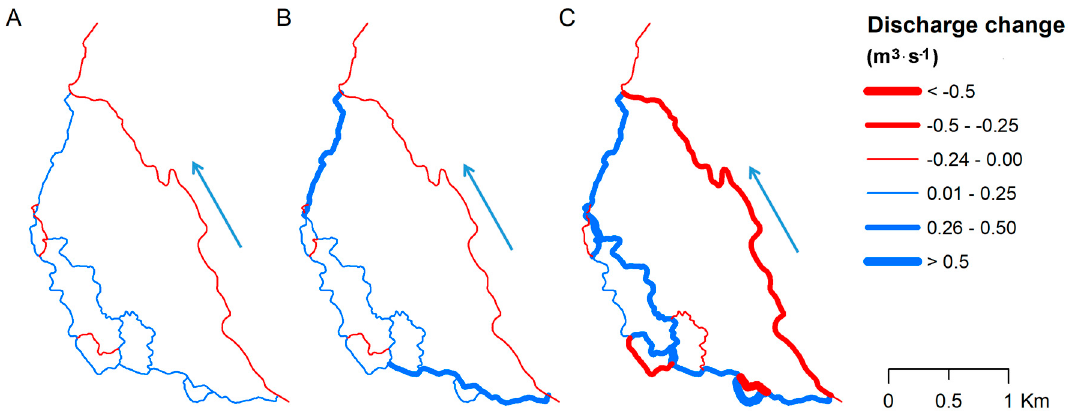
Figure 8. Water flow changes simulated in MFRM: ( A ) summer conditions with vegetation from Group 2; ( B ) summer conditions with vegetation from Group 2; ( C ) winter conditions with vegetation from Group 1. Blue arrow indicates direction of flow.